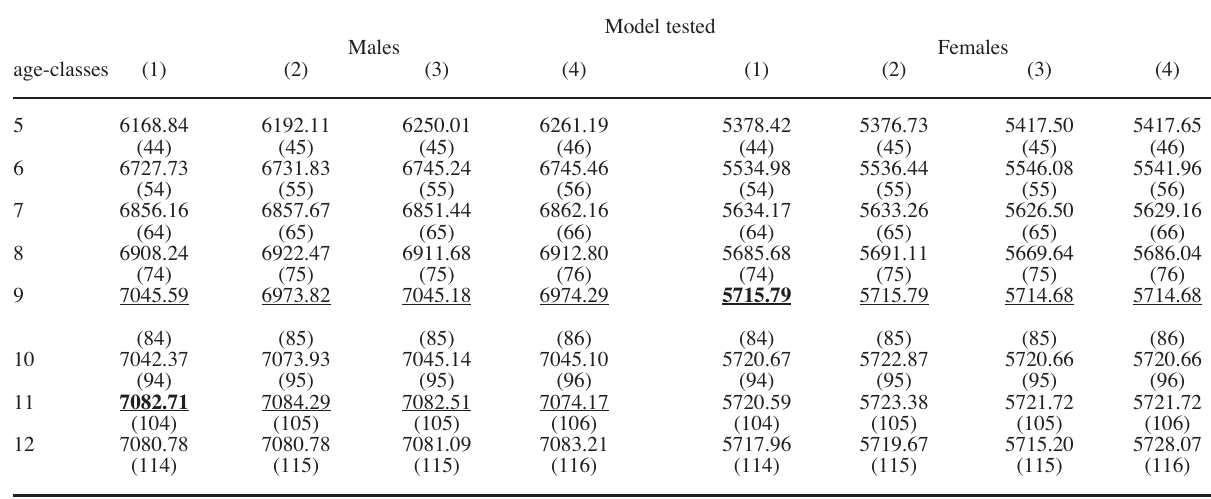
T ABLE 3. – Summary of hypothesis testing for fits for four models to males and females Cervimunida johni . Two times the log-likelihood values are shown for each model with the number of estimated parameters shown below in parentheses. Log-likelihood function values with a single underline are the best fits for each model. The overall are best fit is in